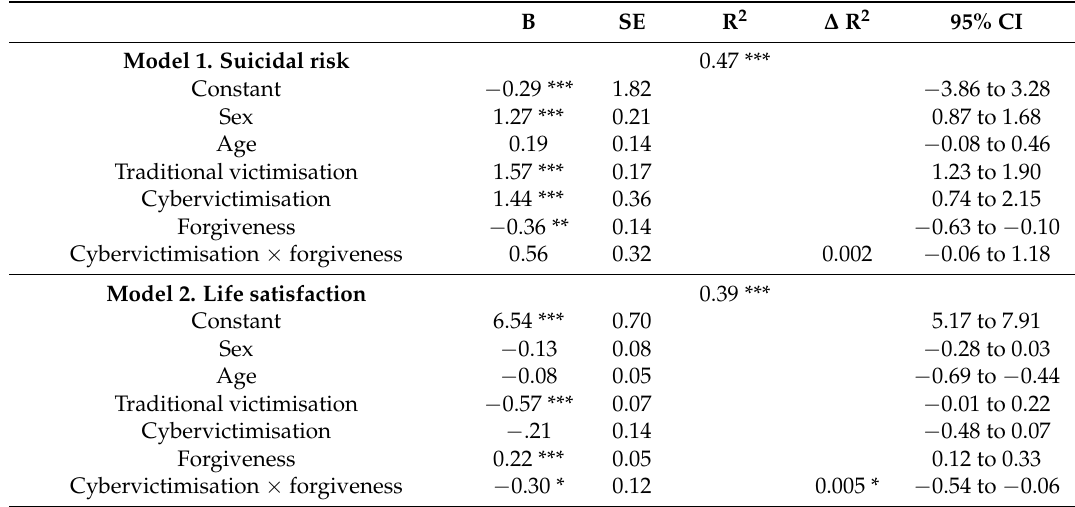
Table 3. Tested moderation models with suicidal risk and life satisfaction as outcomes predicted by cybervictimisation, forgiveness and multiplicative interaction terms. B SE R 2 ∆ R 2 95% CI Model 1. Suicidal